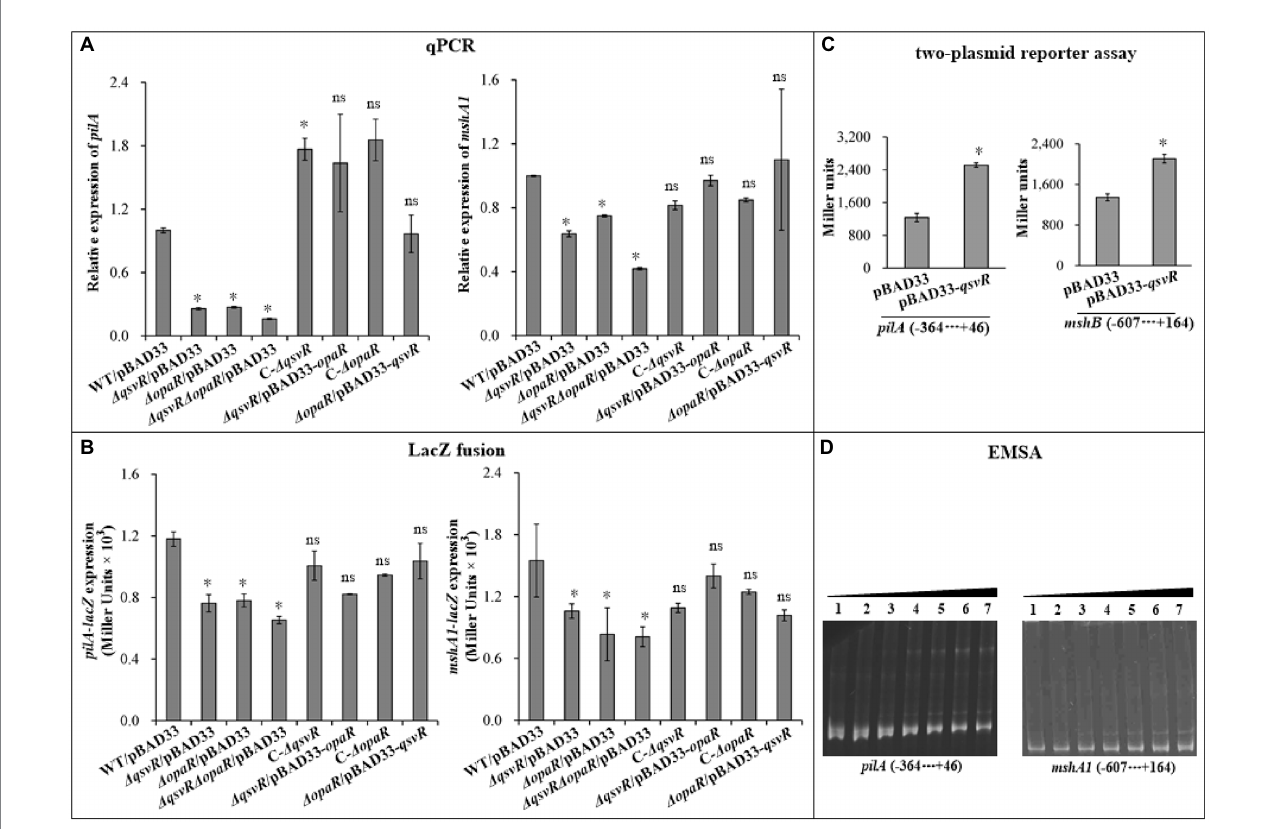
FIGURE 3 Regulation of mshA1 and pilA by QsvR and OpaR. qPCR (A) , LacZ fusion (B) , Two-plasmid reporter assay (C) , and EMSA (D) were carried out as described in Figure 2. Lanes 1, 2, 3, 4, 5, 6, and 7 in the EMSA (D) data contain 0, 0.021, 0.042, 0.063, 0.083, 0.11 and 0.13 pmol of His-QsvR, respectively. Negative and positive numbers indicate the nucleotide positions upstream and downstream of each target gene, respectively. The asterisks indicate statistical significances relative to WT/pBAD33 or E. coli 100 λ pir/pBAD33 ( p < 0.01). The ‘ns’ means no significant differences ( p > 0.01).